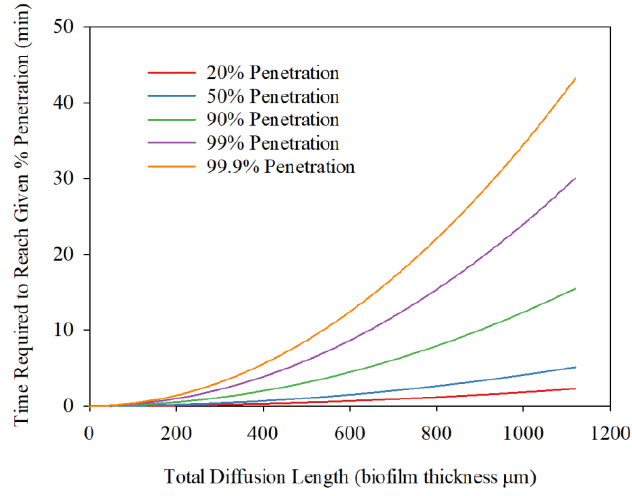
Figure 7. Estimated time required for di ff usion out of H 2 S from biofilm.